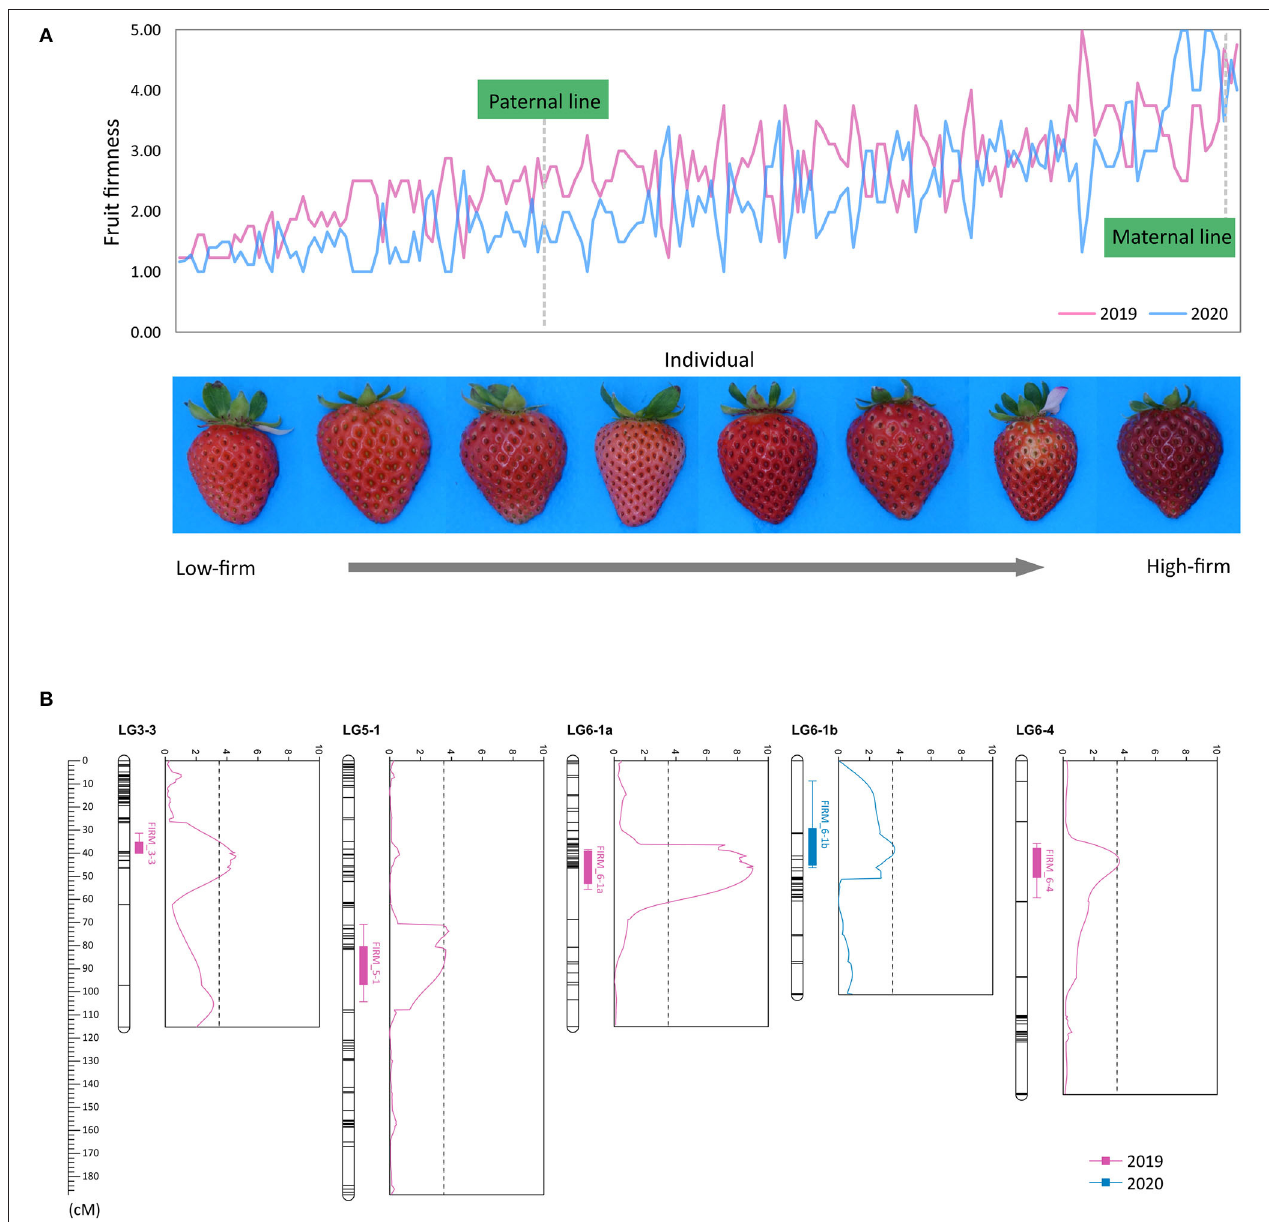
FIGURE 3 | (A) Distribution of fruit firmness in ‘BS F 2 (II)’ evaluated in (a) 2019 and (b) 2020. (B) Positions of five quantitative trait locus (QTLs) associated with firmness marked in the genetic map, along with the logarithm of the odds (LOD) graph.